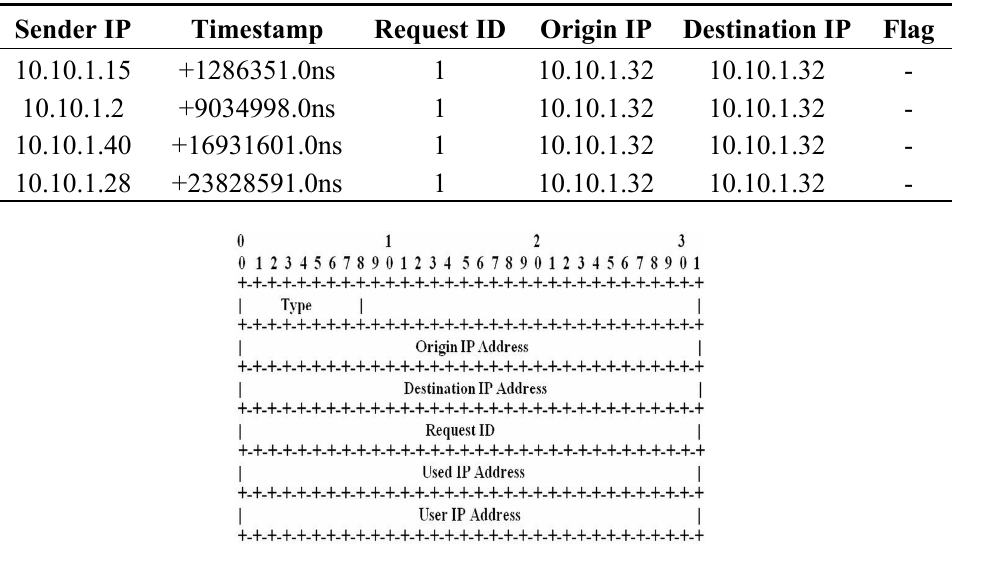
Figure 2. Link info control